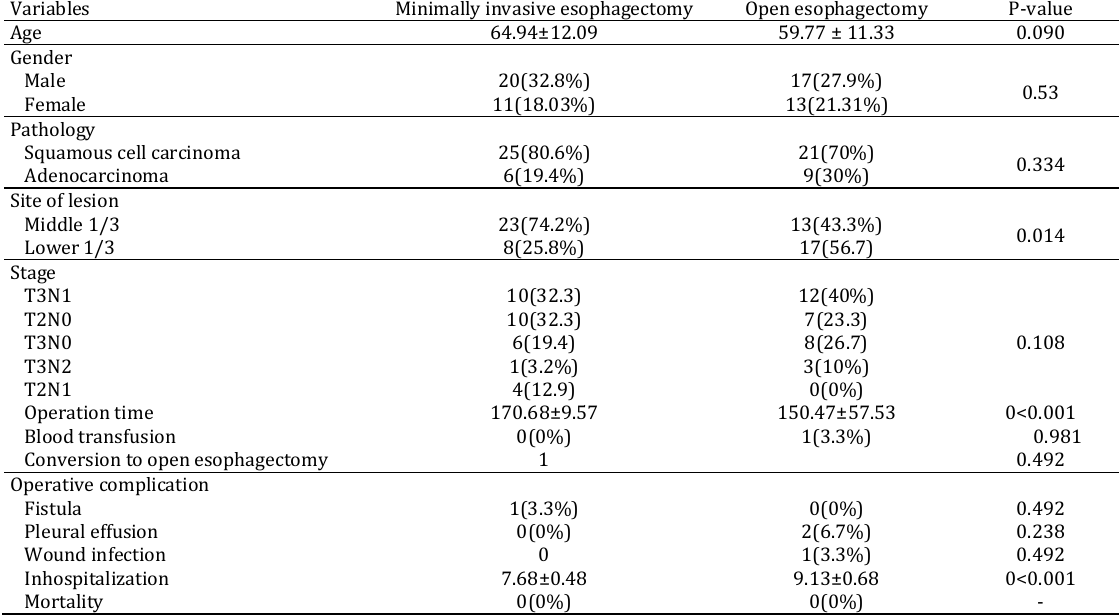
Table 1. Pre- and post-operative outcomes of minimally invasive and open esophagectomy